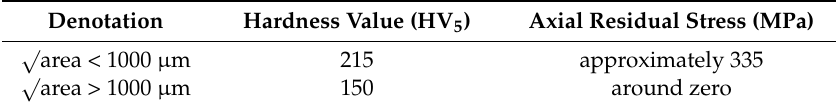
Figure 4. Resulting residual stress state in axial direction of the specimen geometry (in MPa) [30].